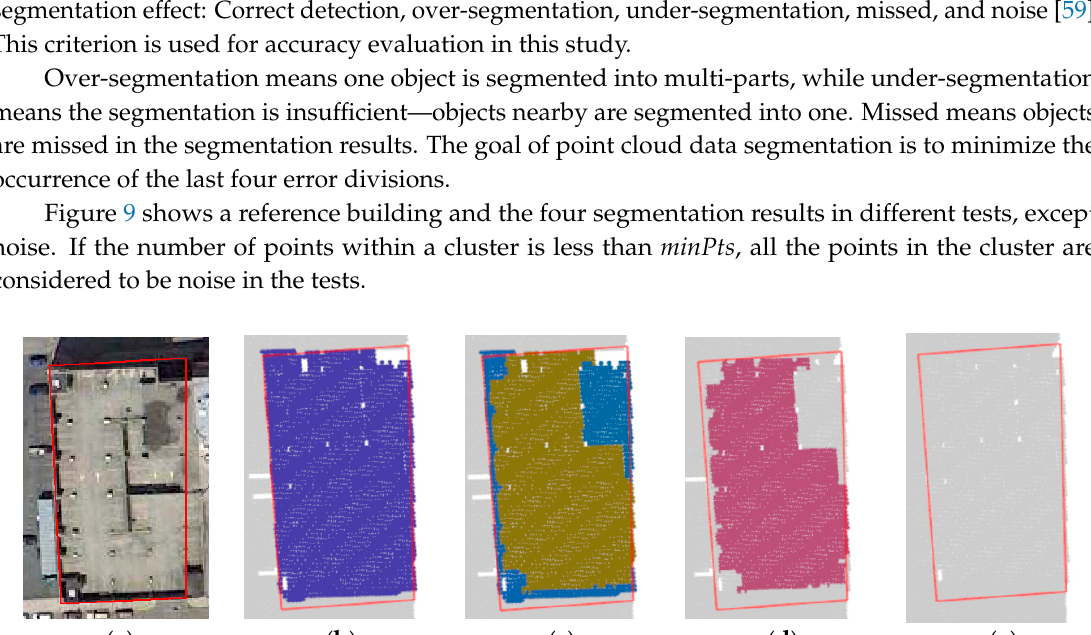
Table 2. Accuracy evaluation using different ε for airborne laser scanning data using X , Y , Z fields.